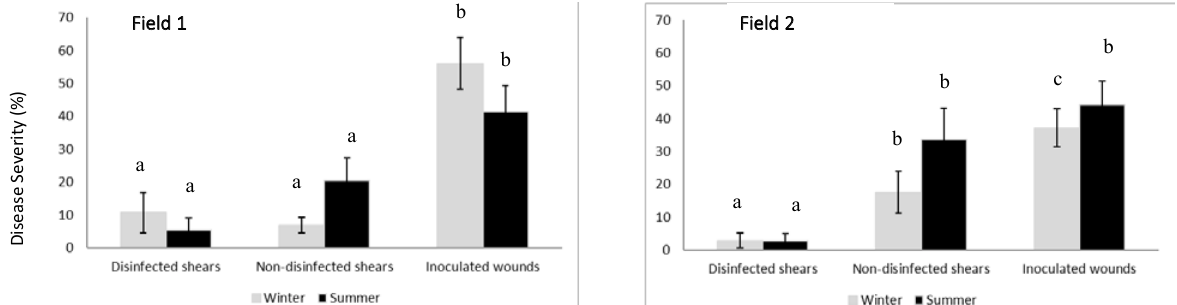
Figure 1. Percent (%) Calosphaeria canker severity in branches of sweet cherry trees 6 months after application of different pruning treatments. Mean percentages are based on ten replicates per treatment. Within each season, means accompanied by the same letter are not significantly different (P> 0.05). Bars represent the standard errors of the